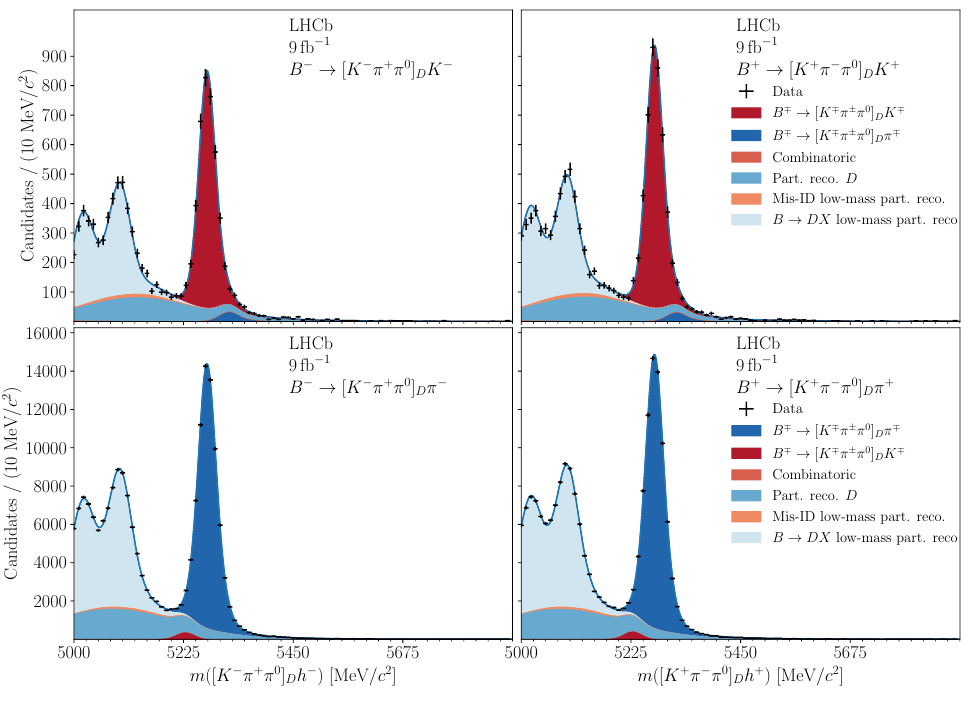
Figure 1 . Mass distributions of B ∓ → [ K ∓ π ± π 0 ] D K ∓ (top) and B ∓ → [ K ∓ π ± π 0 ] D π ∓ (bottom) candidates, separated by charge.